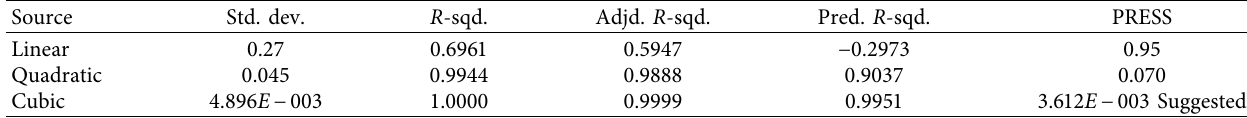
Table 9: Model summary statistics for compressive strength response.